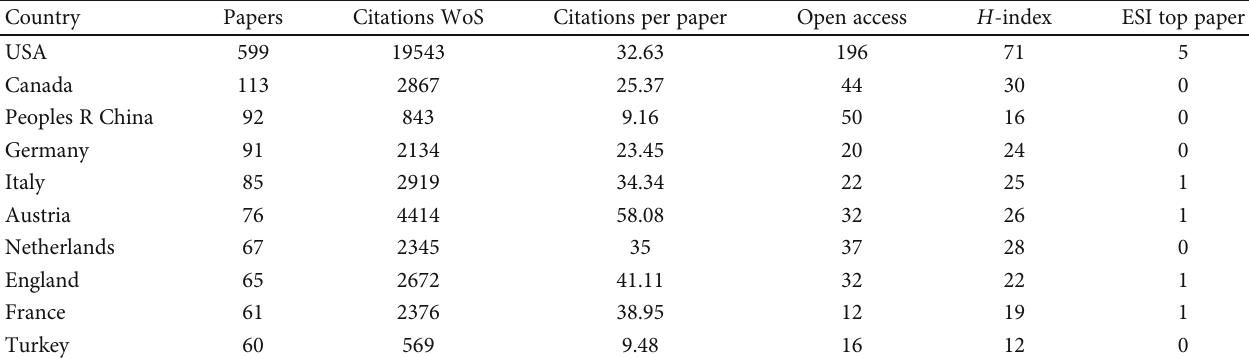
Table 1: The top 10 countries of origin of papers in neuropathic pain rehabilitation research.